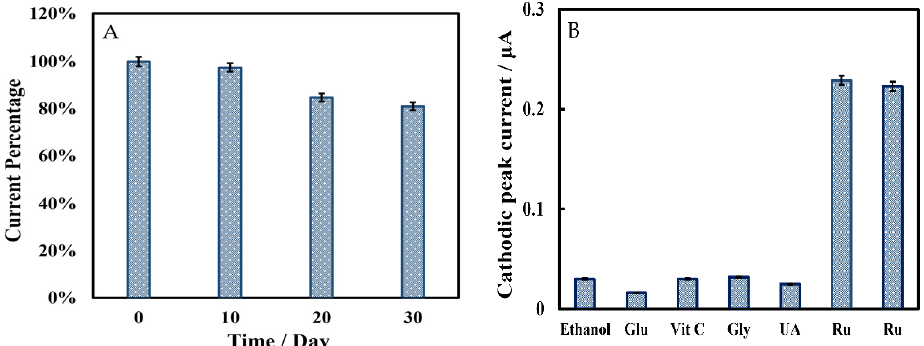
Table 2. The IF values of different interfering substances.